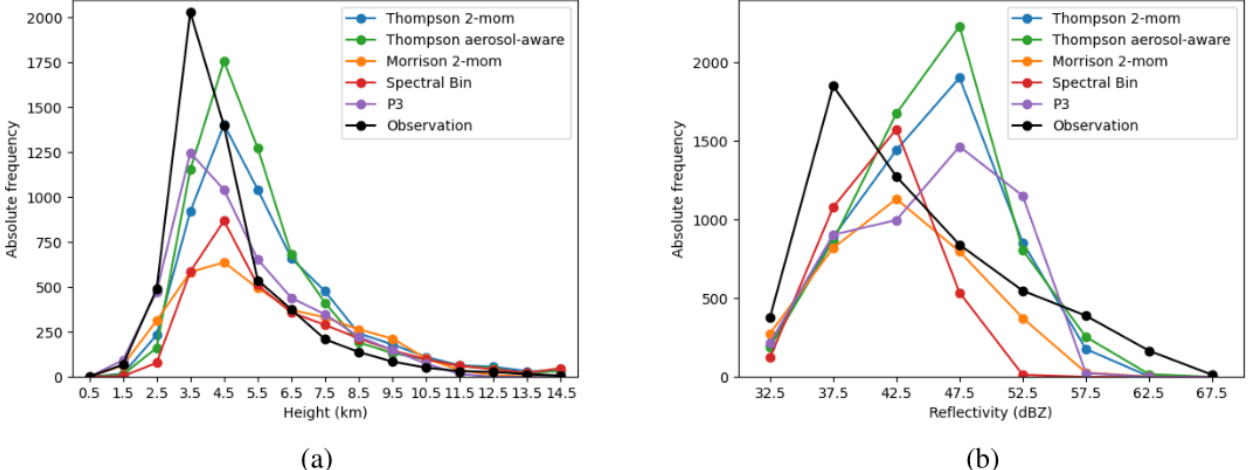
Figure 4. Cell core height (a) and cell maximum reflectivity (b) distribution for inner simulation domain over 30 convection days for observations and five microphysics scheme